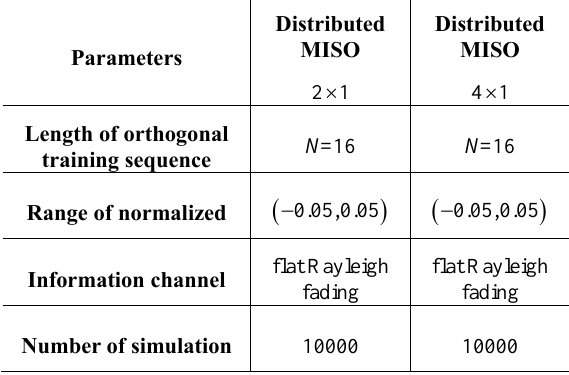
Fig.6 and Fig.7 indicates the performance comparison results in 2 1 × and 4 1 × distributed